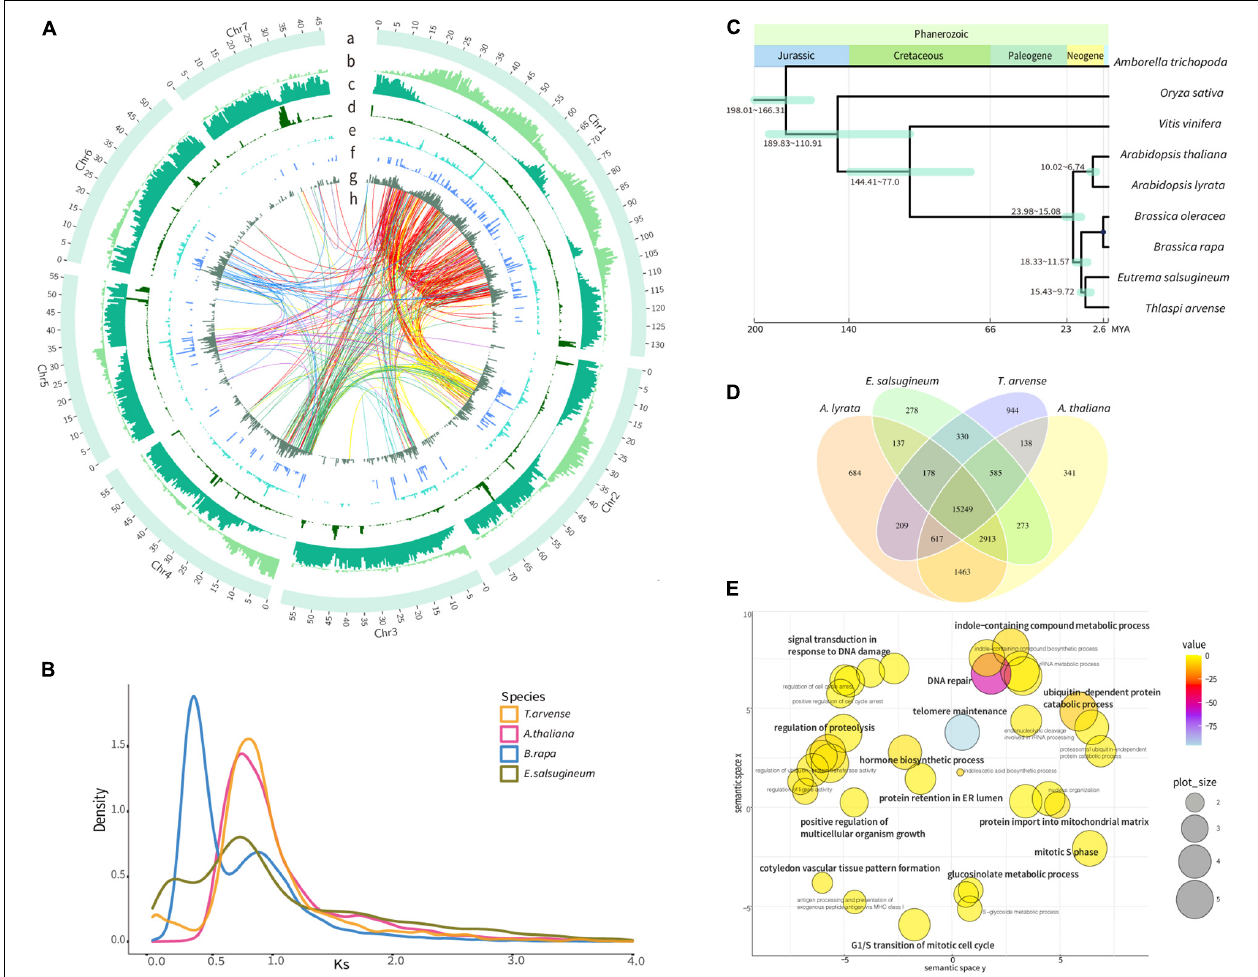
FIGURE 1 | Genome features and evolutionary analyses of the Thlaspi arvense genome. (A) Distribution of genomic features [Track a, seven chromosomes. One scale label indicates 1 Mb. Track b, gene density indicated by gene length/500 Kb. Track c, Gypsy LTR-RTs density, indicated by Gypsy length/500 Kb. Track d, Copia LTR-RTs density, indicated by Copia length/500 Kb. Track e, LINE density, indicated by LINE length/500 Kb. Track f, SINE density, indicated by SINE length/500 Kb. Track g, DNA transposons density, indicated by DNA transposons length/500 Kb. Region h, transpositions tracks of the retrogene from its parental gene in Chr 1–7 are colored in red, yellow, light blue, green, purple, blue, and light purple lines, respectively]. (B) Density plot of the rate of synonymous distribution (Ks) values of the best reciprocal BLASTP hits in the genomes of T. arvense , Eutrema salsugineum , Brassica rapa , and Arabidopsis thaliana . (C) The phylogenetic tree of T. arvense with eight other angiosperms. (D) Venn diagram showing unique and shared orthogroups between genomes of T. arvense and three Brassicaceae close relatives. (E) REViGO semantic similarity scatterplot of the GO enrichment of significantly expanded orthogroups in T. arvense [bubble color indicates the provided p -value; bubble size indicates the frequency of the GO term in the underlying database (bubbles of more general terms are larger)].